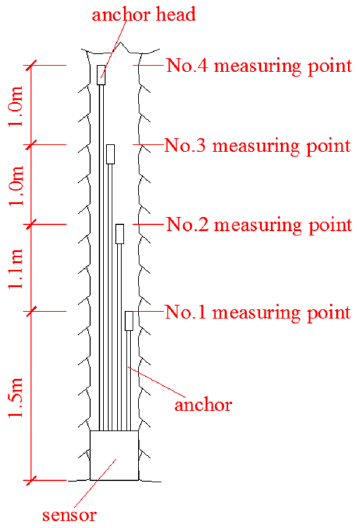
Figure 4. Multi-point Figure 4. Multi ‐ point extensometer. Figure 4. Multi ‐ point extensometer.